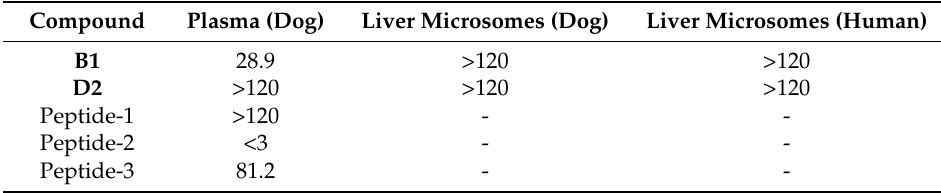
Table 1. Half-lives (minutes) of B1 and D2 and control peptides 1 in plasma and liver microsomes.